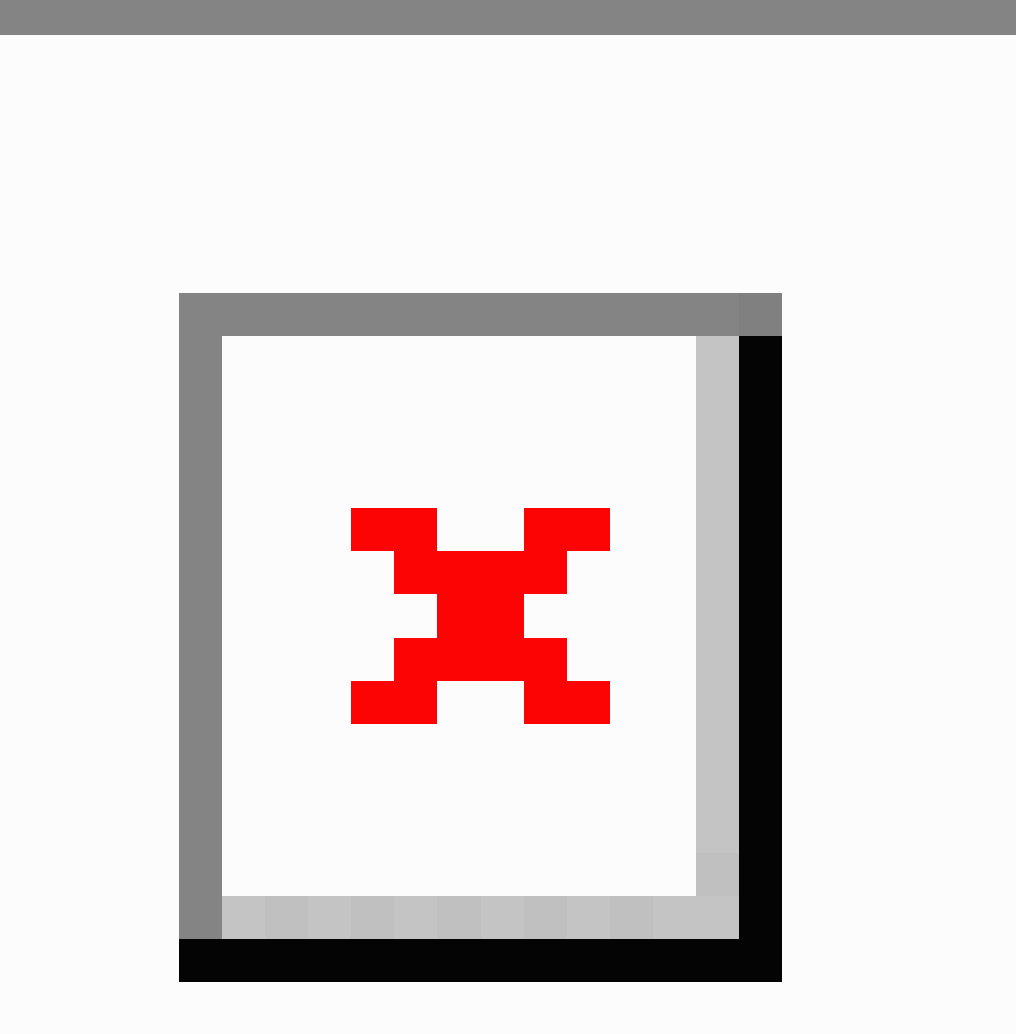
Figure 1. Observed and forecasted enrollment trends over 5 years: July 2012-June 2017. Total users denote women registered to receive MAMA messaging while comprehensive care refers to the subpopulation that attended all recommended antenatal care 1 to 4 visits and had children that received the fully package of